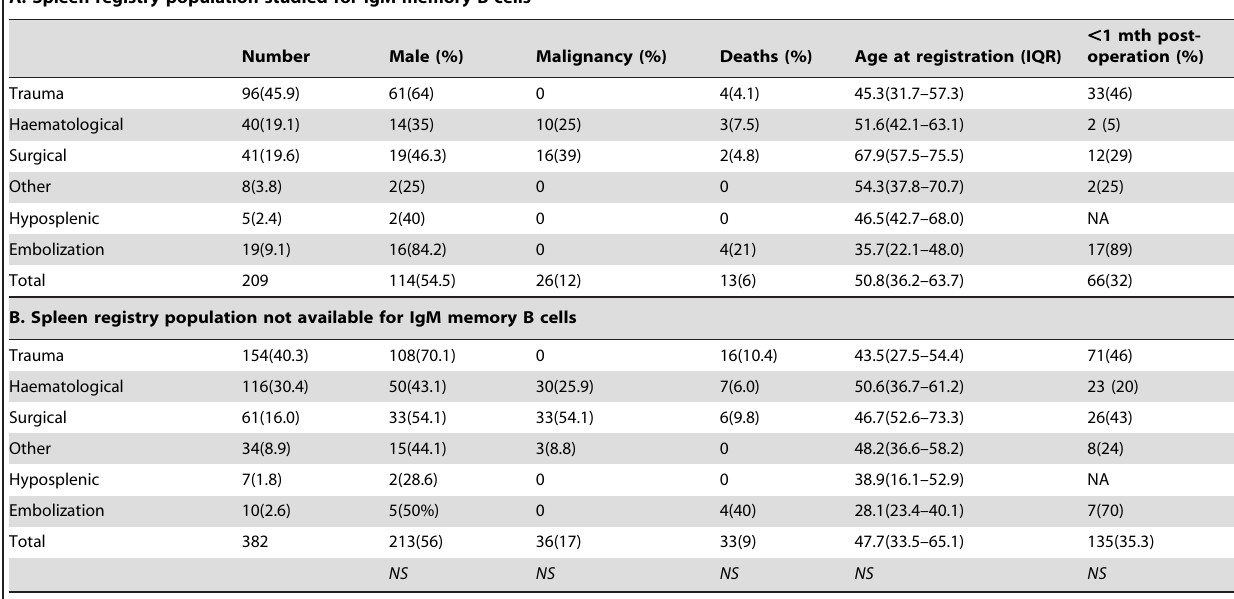
Table 1. Demographics of spleen registry